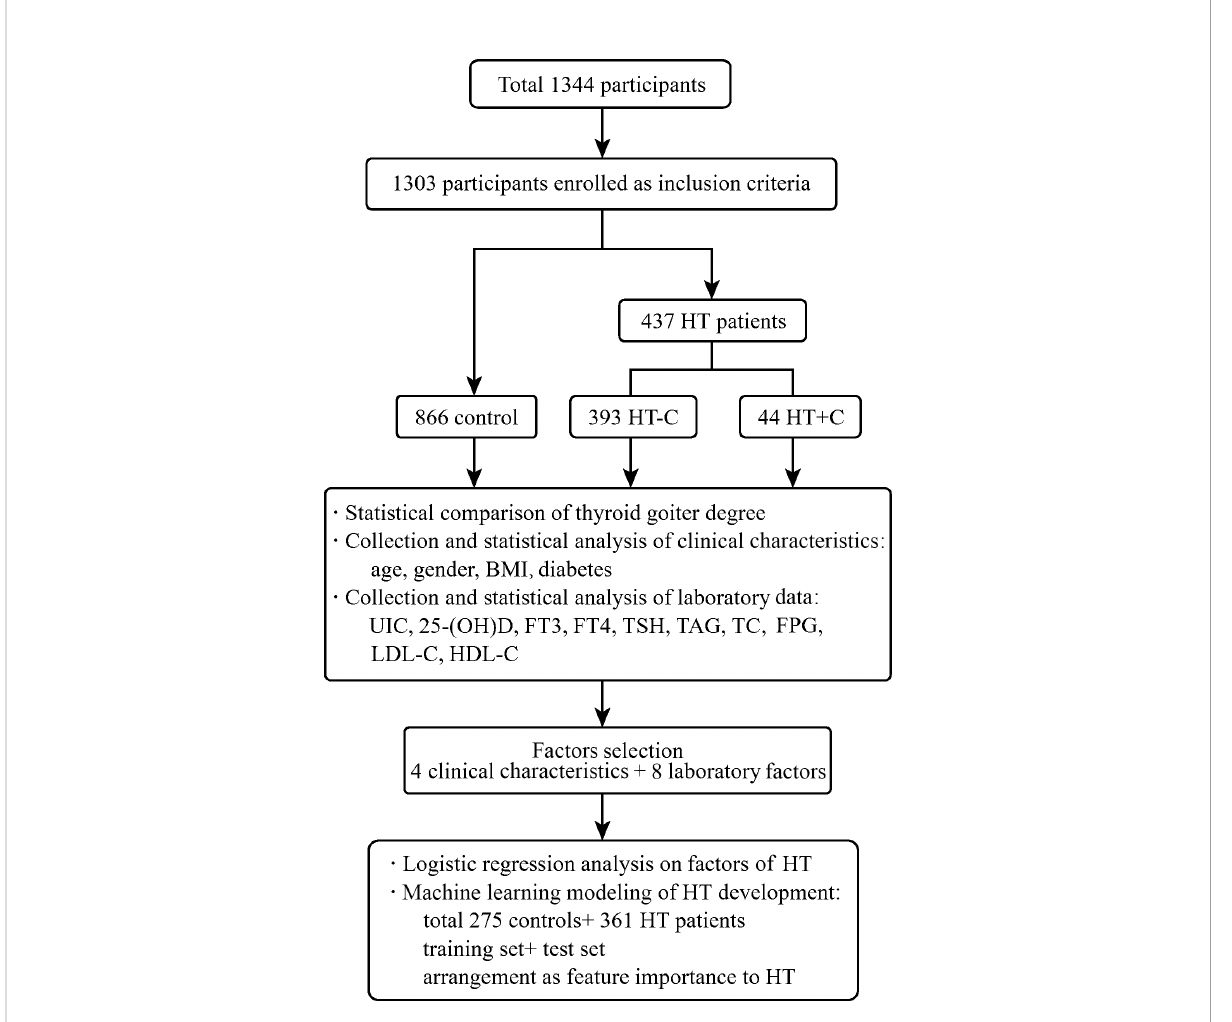
FIGURE 1 Overview of the cohort study. The fl ow chart shows the participants selection and classi fi cation, statistical analysis and logistic regression analysis on multiple factors of controls and patients, as well as machine learning modeling and evaluation of HT